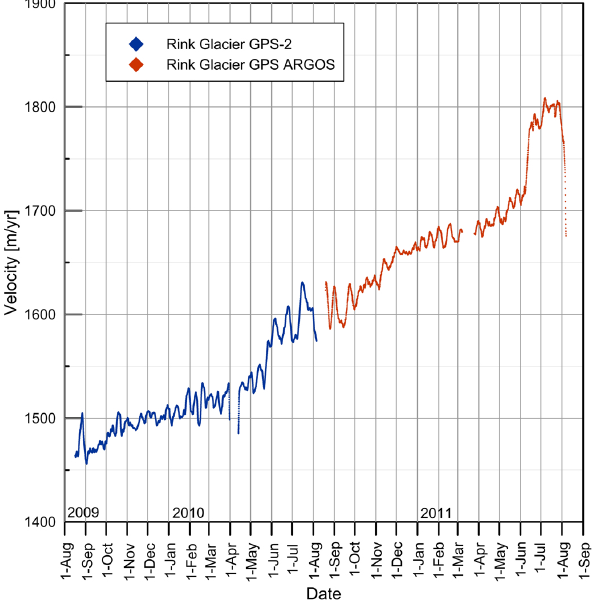
and Table 1 for instrument position and operational period). The ARGOS GPS was deployed at the retrieval position of GPS-2. Note the e ff ect of the GPS instruments being advected towards faster moving parts of the